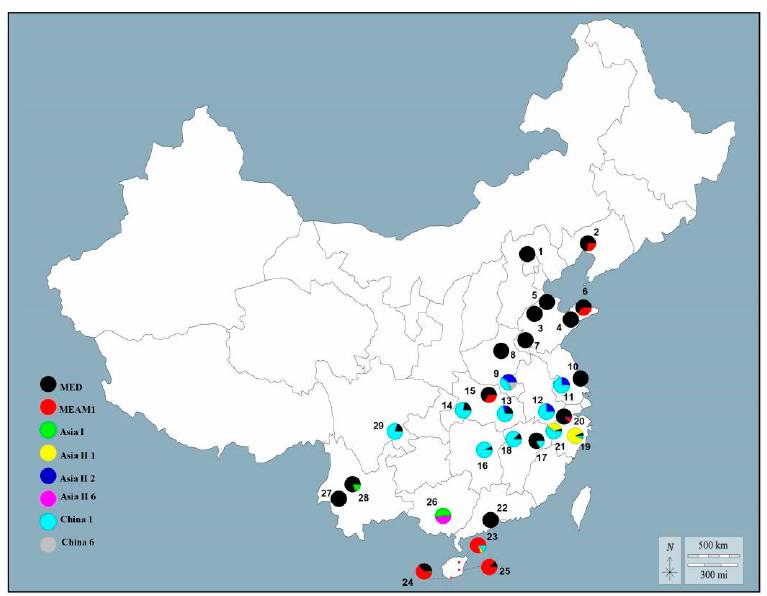
Figure 2. Geographical distribution of Bemisia tabaci cryptic species across China in 2021. The pies represent the percentage of cryptic species in each natural population; numbers indicate sampling population numbers defined in Table S1, Supporting Information.